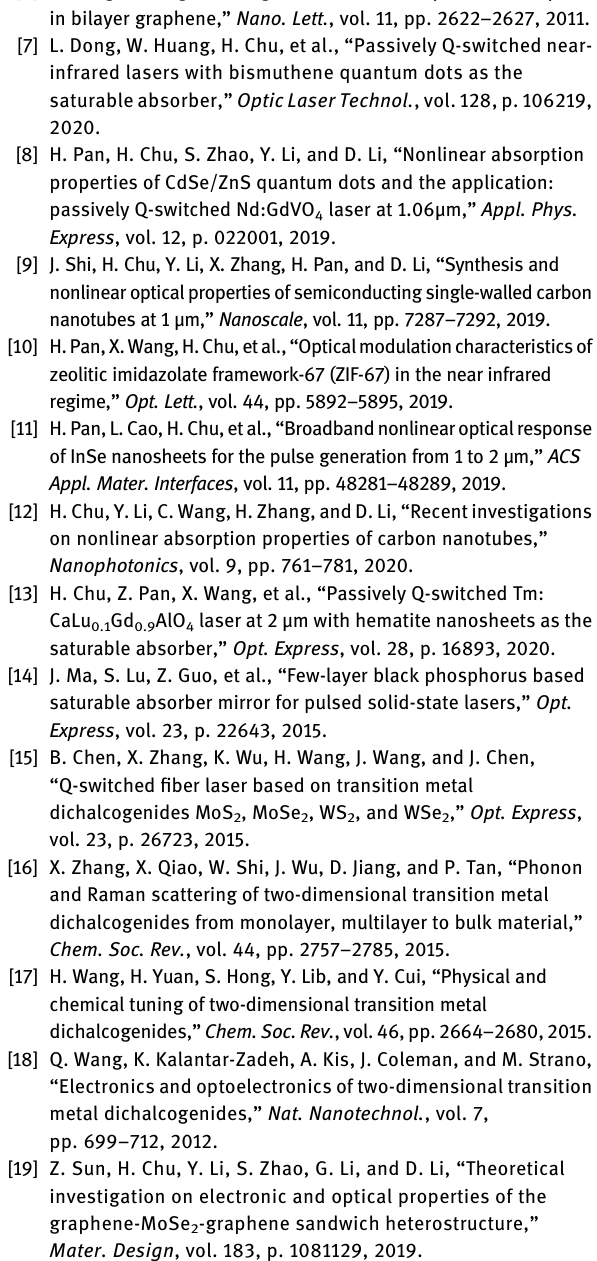
Figure 7: (A) The working spectrum of the single-crystalline monolayer molybdenum disulfide (MoS 2 ) Q-switched Tm,Ho:CLGA laser and inset: spontaneous emission spectrum of Tm,Ho:CLGA crystal; (B) the beam quality M 2 factor at the absorbed pump power of